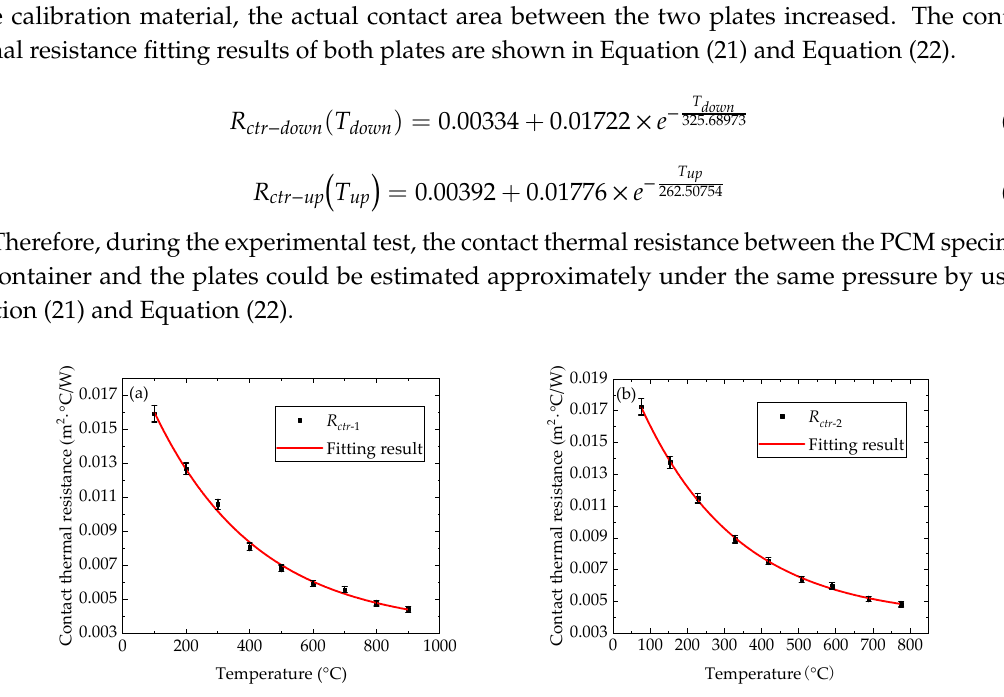
Figure 6. The calibration results of contact thermal resistance at different heating temperatures. ( a ) Hot plate. ( b ) Cold plate.